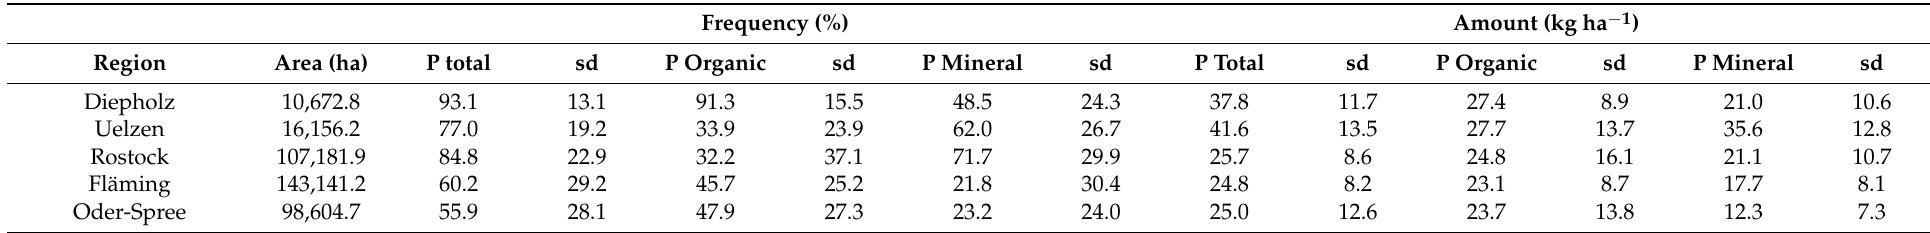
Table A1. Indicator frequency displayed in Figure 3 ± standard deviation (sd) of P used on the whole area: P total, organic and mineral P used. Indicator amount ± standard deviation of P used on the treated area only. All values are given per region (Diepholz, Uelzen, Rostock, Fläming and Oder-Spree) for the study period 2010–2018.